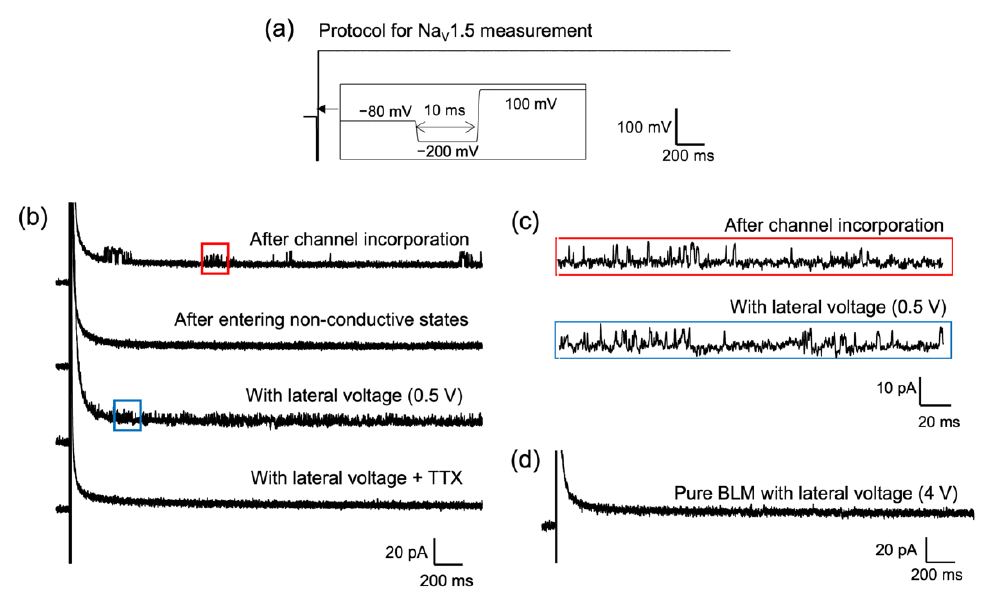
Figure 9. ( a ) Transmembrane voltage protocol for recording Na V 1.5 channel currents; ( b ) sequentially measured transmembrane currents after incorporation of the channel; ( c ) detailed channel activities marked by red and blue squares in ( b ); ( d ) the transmembrane current of a BLM without channels under a lateral voltage of DC 4 V. Current signals were filtered at 2kHz with a low-pass Bessel filter and digitized at 25 kHz. Reprinted with modification from Ref. [11]. Copyright 2022 The Royal Society of Chemistry.